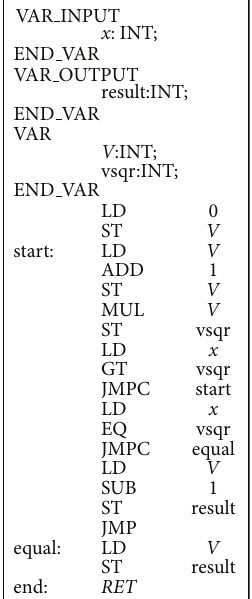
Figure 11: IL program.